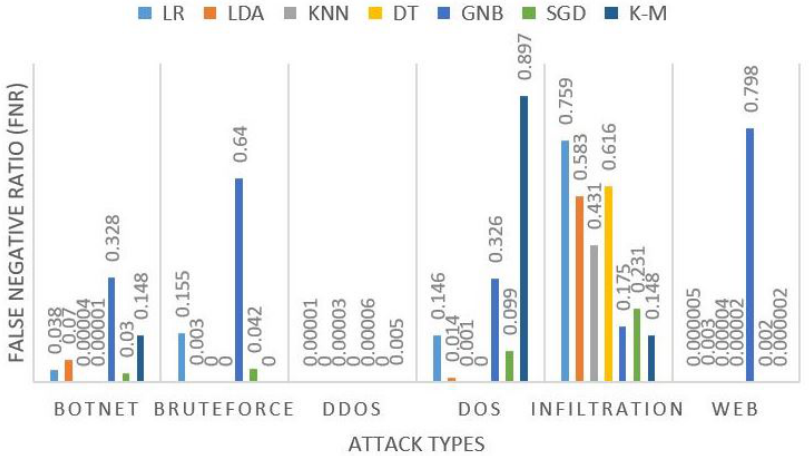
Figure 13. False Negative Rate (FNR) of different ML approaches based on various attack types.